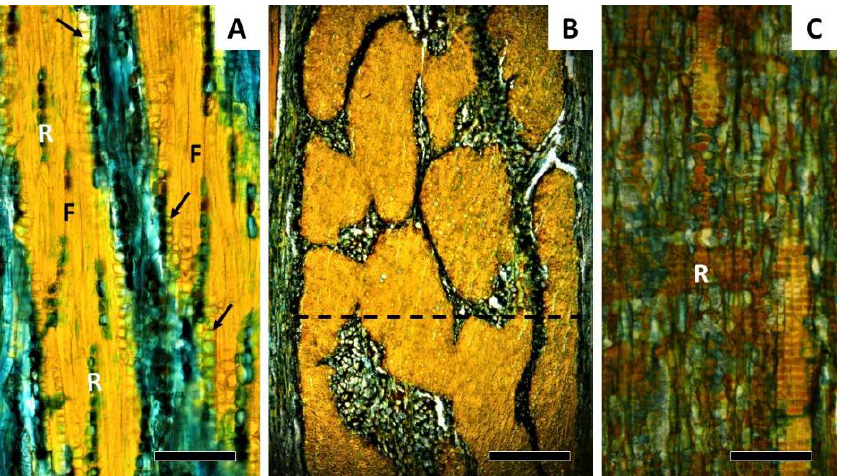
Figure 5. Longitudinal sections of secondary phloem of Quercus rotundifolia (tangential A,B and radial C, sections). ( A ) Uniseriate rays (R), fibers (F) bordered by a series of crystalliferous cells (arrows). ( B ) A large ray (—) with strongly lignified parenchyma cells. ( C ) Rays of homogeneous type (R) with procumbent cells filled with contents of brown color. Scale bar: A = 65 µ m; B = 300 µ m; C = 160 µ m.